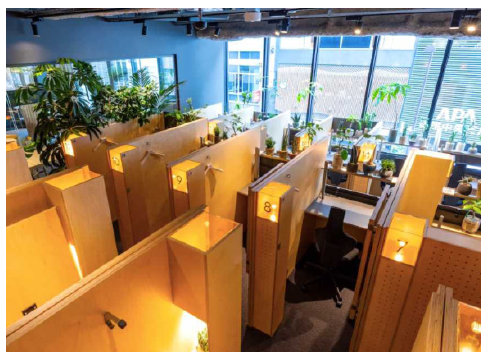
Figure 32. Think Lab, Starbucks collaboration store [83].